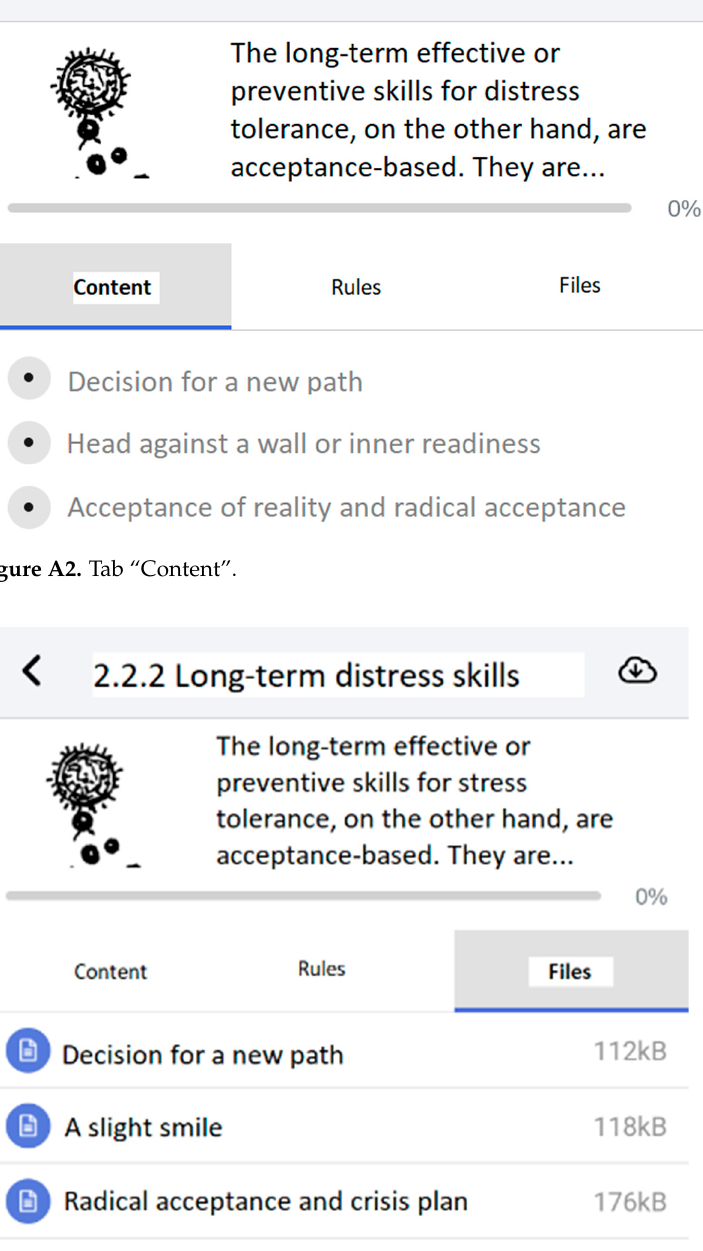
Figure A3. Tab Figure A3. Tab “Files”.